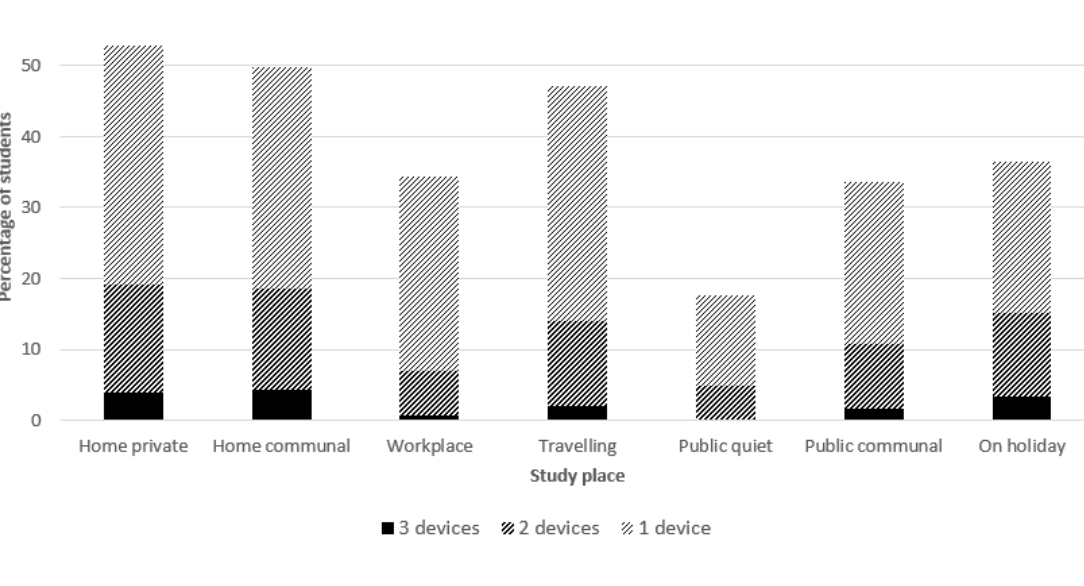
Figure 2. Percentage of handheld devices used ( n